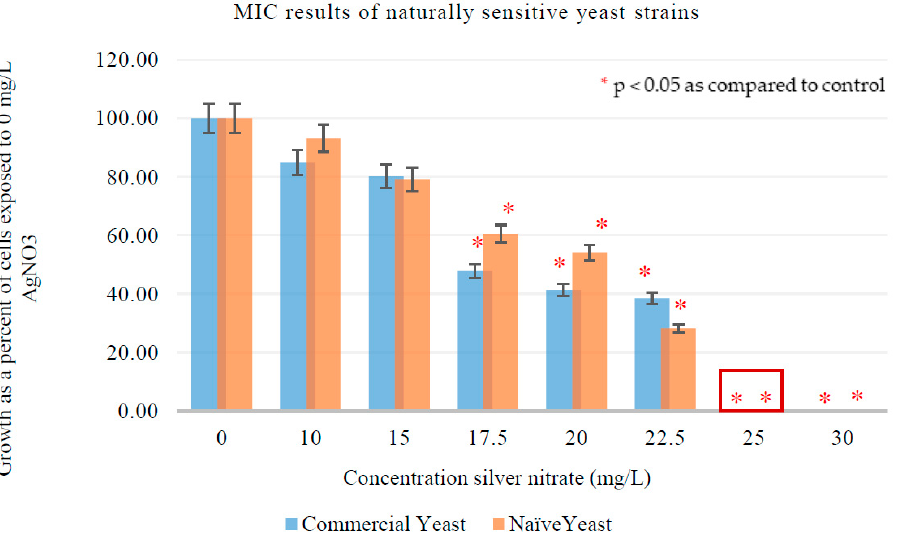
Figure 2. Minimal inhibitory concentration of AgNO 3 for NS commercial ( n = 10) and naïve ( n = 10) yeast. The red asterisk represents AgNO 3 concentrations that resulted in significantly less ( p < 0.05) growth when compared to the control. The red box represents growth that occurred at the MIC. Error bars represent percentage error (5%).